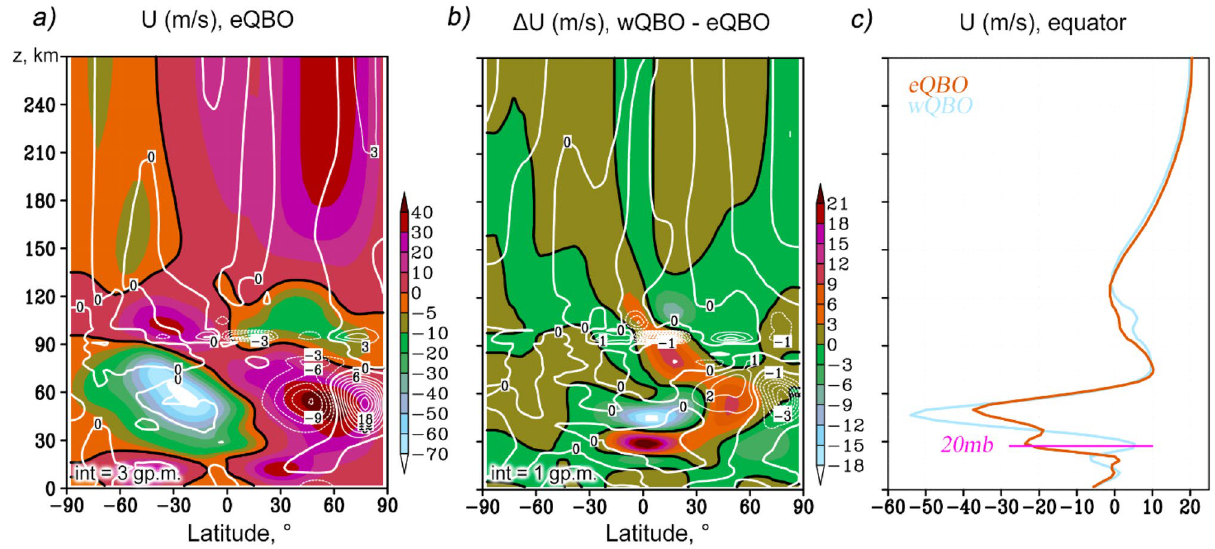
Figure 1. Latitude-height distributions (shaded) of the zonal-mean wind (m/s, a ), according to MUAM ensemble for January–February, eQBO; respective zonal mean wind increments due to change from wQBO to eQBO ( b ); vertical profiles of the equatorial zonal wind for both QBO phases ( c ). Contours in the panels ( a , b ) reveal EP-flux divergence and its increments in 10 –2 m 2 /s 2 /day,